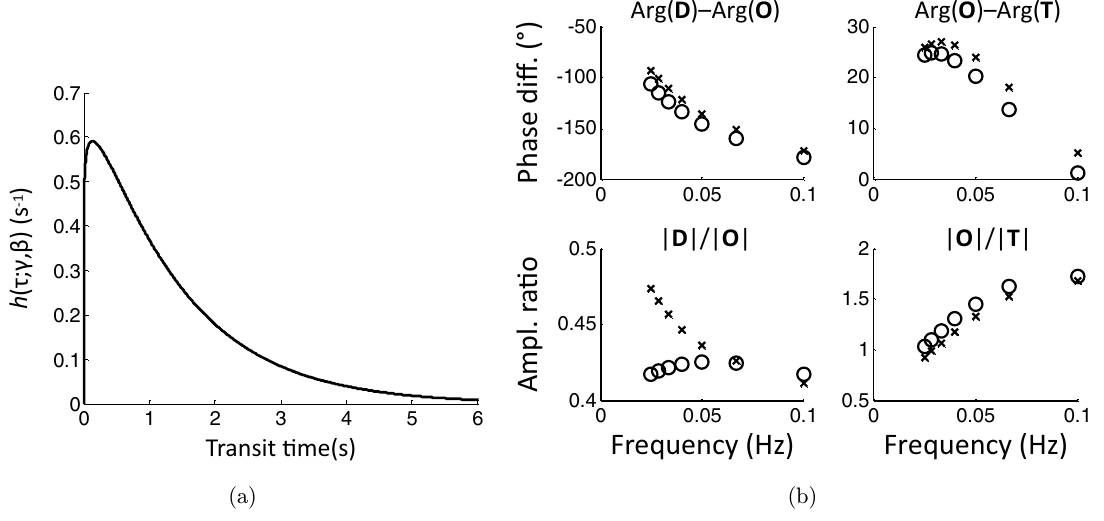
Fig. 2. (a) pdf of the capillary transit time ½ h ð (cid:2) ; (cid:3);(cid:4) Þ(cid:1) for (cid:3) ¼ 1 : 108 and (cid:4) ¼ 1 : 26 s, which yield h (cid:2) i (cid:5) 1 : 4 s and (cid:5) ð (cid:2) Þ (cid:5) 1 : 33 s. (b) CHS spectra of phase di®erences [Arg( D ) (cid:2) Arg( O ) and Arg( O ) (cid:2) Arg( T )] and amplitude ratios [ j D j = j O j and j O j = j T j ] as a function of the oscillation frequency. The crosses represent data obtained with the original model, whereas the empty circles represent data obtained with the extended